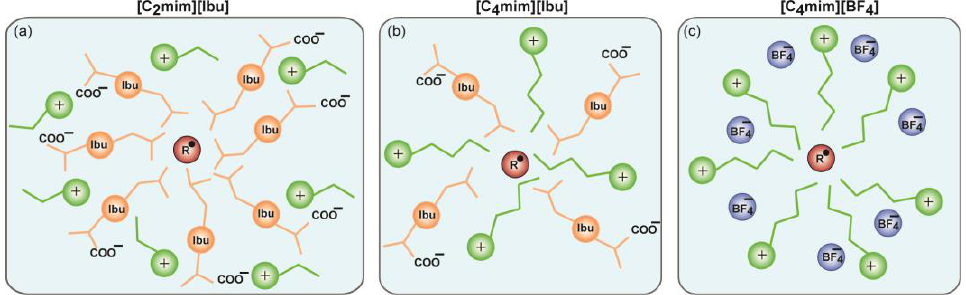
Figure 4. The images of the partly ordered hypothetical heterogeneous microstructures of representative ILs around the dissolved-radical probe. ( a ) Microstructure in case of IL with small alkyl moiety of cation: the micelle around the spin probe is formed by alkyl moieties of anions. ( b ) Microstructure in case of IL with alkyl moieties of comparable size in cations and anions: both kinds of ions form radical surrounding. ( c ) Microstructure in case of IL with no alkyl moiety in anion: the radical surrouinding is formed by aklyl chains of cations.